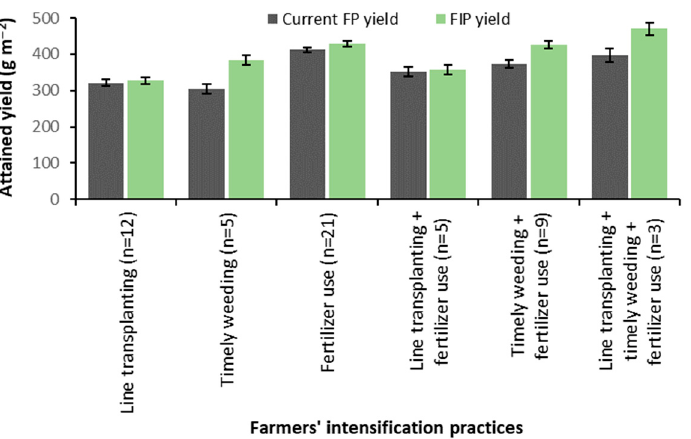
Figure 5. Attained yield under current farmers’ practice and different intensification practices within the fields of the same farmers who implemented the intensification practices, Doho 2019. Current farmers’ practice did not include improved management practices under farmers’ intensification practice. Error bars are twice standard error of means, and n is the number of farmers who implemented the different intensification practices. FP = farmers’ practice and FIP = farmers’ intensification practice.